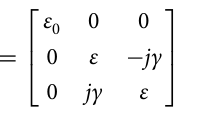
resonance, as shown in Fig. 2g, h. The measured transmission spectra under s- and p-polarization for normal incidence are